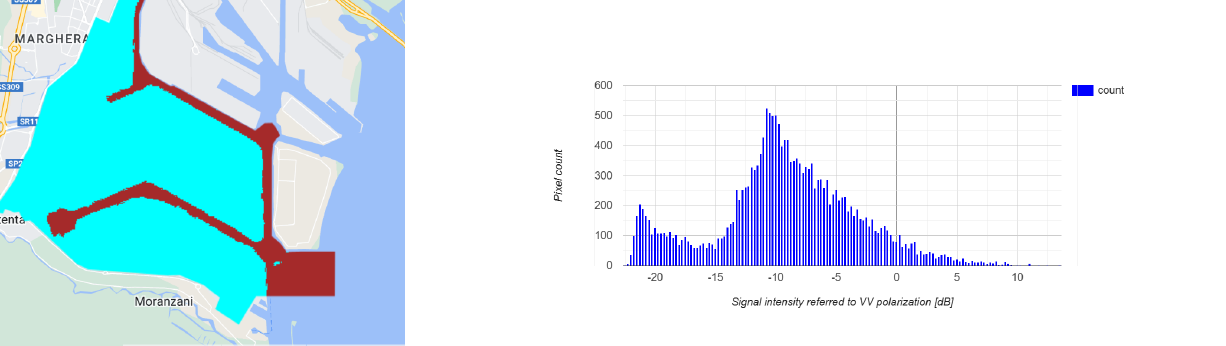
Figure 6. Histogram for SAR threshold selection.